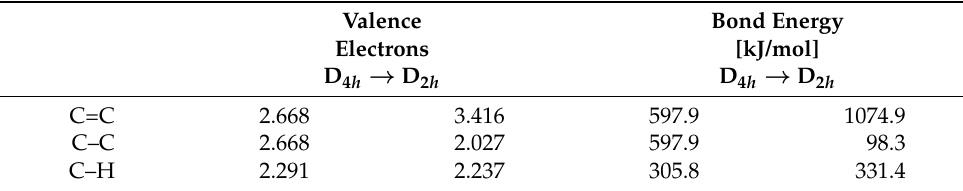
Table 2. Relative valence electron counts and bond